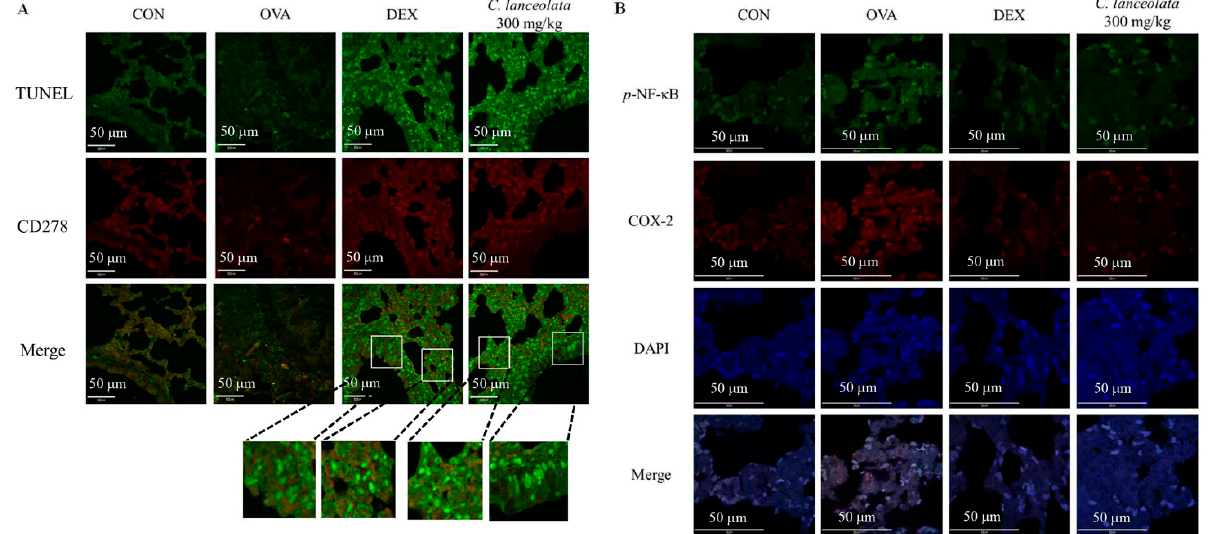
Figure 4. C. laceolata stimulated the cell death (apoptosis) of Th2 cells and pulmonary epithelial cells via the NF- κ B/COX-2 pathway. ( A ) C. laceolata induced apoptosis on both the Th2 cells and bronchioalveolar epithelial cells compared to the result in the ovalbumin treatment group. It was difficult to observe the apoptotic cells both in the vehicle control group and in the ovalbumin treatment group. Although the dexamethasone treatment and 300 mg/kg/day C. laceolata treatment upregulated the apoptosis, the number of apoptotic cells in the 300 mg/kg/day C. laceolata treatment group (magnified parts) was more than that in the dexamethasone treatment group (magnified part). Scale bar, 50 µ m; magnification, × 400. CON, vehicle group; OVA, ovalbumin-induced asthma group; DEX, positive control group (1 mg/kg/day dexamethasone with OVA); C. laceolata 300